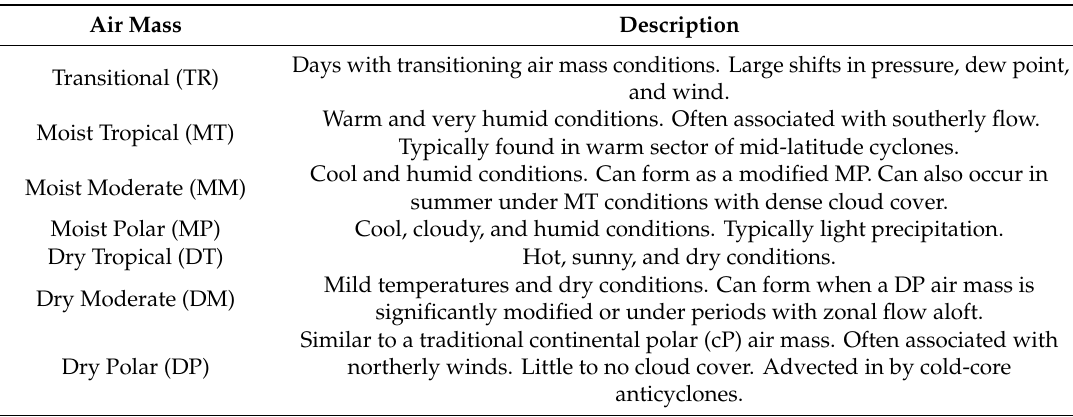
Table 1. Air mass classification type from the spatial synoptic classification